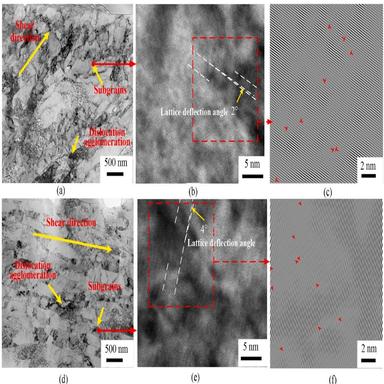
TEM images in the cutting deformation zones at 150 m/min (a)–(c) present the results of the PSZ (area 1 in), while (d)–(f) present the results of the SDZ (area 2 in a). (a) and (d) show the microstructure characteristics after cutting. (b) and (e) are the high-resolution images around the subgrain boundary in (a) and (d), in which the lattice deflection angle was measured and marked. (c) and (f) are the images transformed from the selected areas in (b) and (e) after implementing FFT,